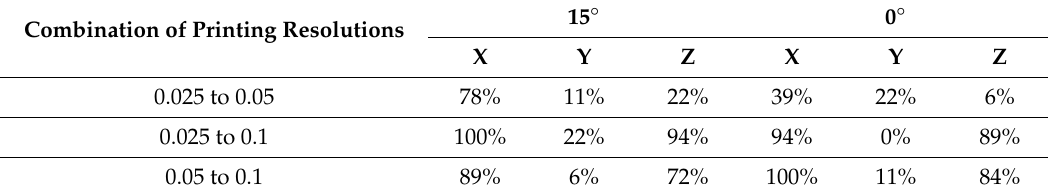
Significances (p ≤ 0.05) within measurement directions depending on the selected printing